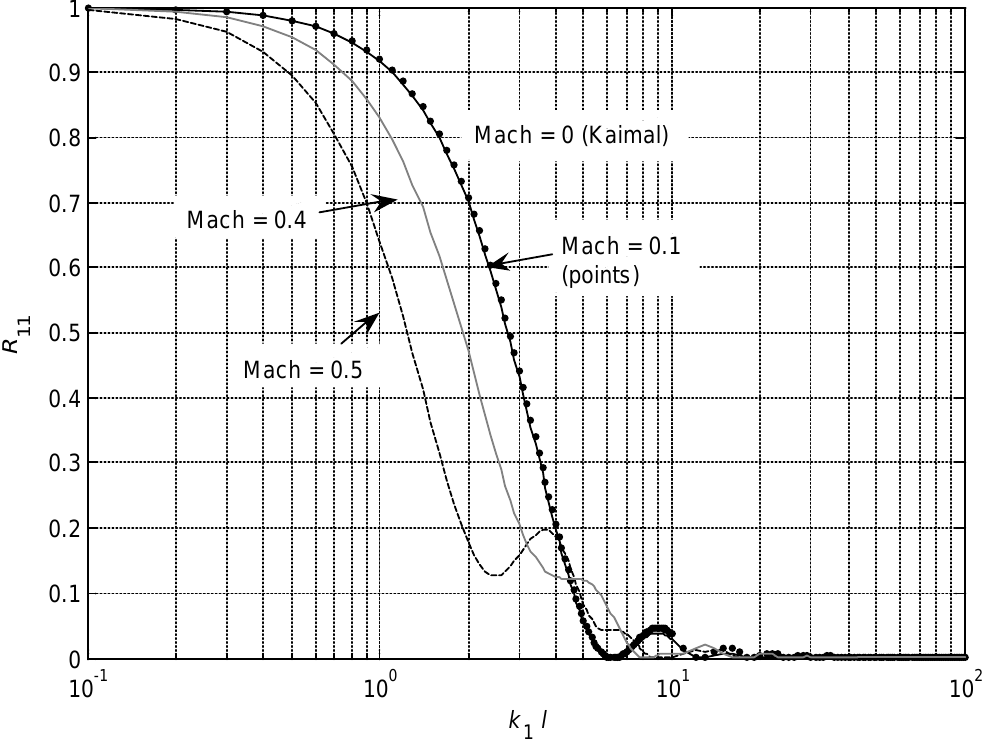
Figure 4. Transfer function of a sonic anemometer for different Mach numbers as a function of the dimensionless spatial frequency k = 0 for all Z B